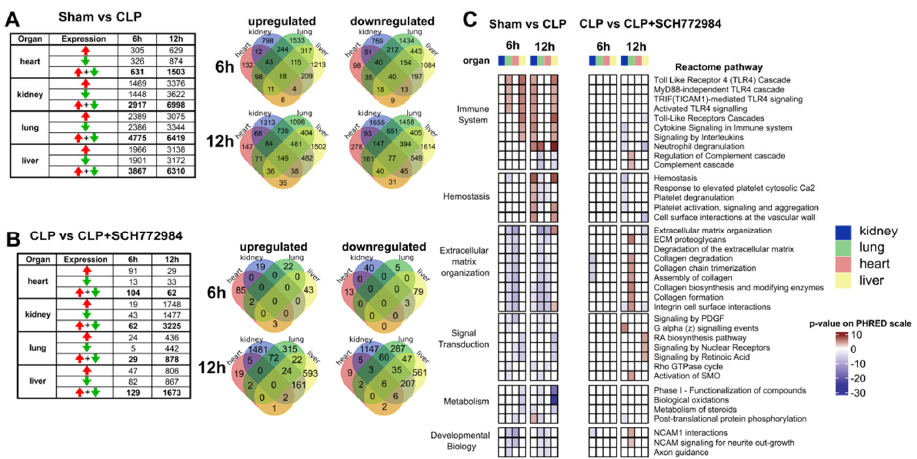
Figure 4. SCH772984 downregulates transcripts associated with the immune response and hemostasis in kidney and liver tissues, and positively regulates ECM and retinoic acid pathways in the lungs and liver, respectively, in a CLP ‐ induced mouse model of sepsis. The numbers of differentially expressed genes (adj. p ‐ value < 0.05) across the organs and two time points in the sham vs. CLP groups (A) and upon SCH772984 (10 mg/kg) treatment (B) . Red and green arrows indicate up ‐ and downregulated genes, respectively. Venn diagrams show the overlapping numbers of DEGs for organs at a given time point post ‐ CLP for up ‐ and downregulated genes. (C) Significantly altered (adj. p ‐ value < 0.05) recurrent Reactome terms across the organs and time points in the sham vs. CLP and the CLP vs. CLP+ SCH772984 groups. The Reactome pathways with a differential gene ratio higher than 10% and recurrently altered in more than two types of samples are shown. The p ‐ value is shown on the PHRED scale and is reversed for downregulated pathways.